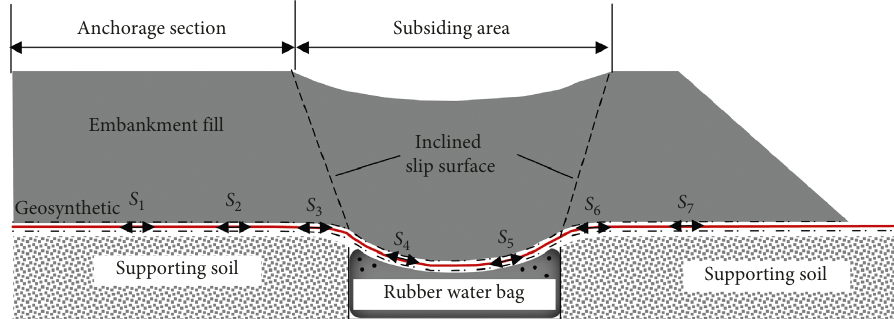
Figure 12: The rubber water bag trapdoor test conducted by Miao et al. [35].